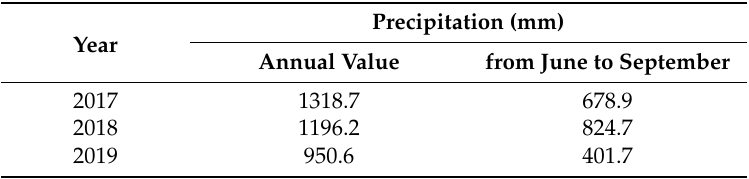
Table 1. Annual and summer season sum of precipitation between 2017 and 2019 (Data source: the Institute of Meteorology and Water Management - National Research